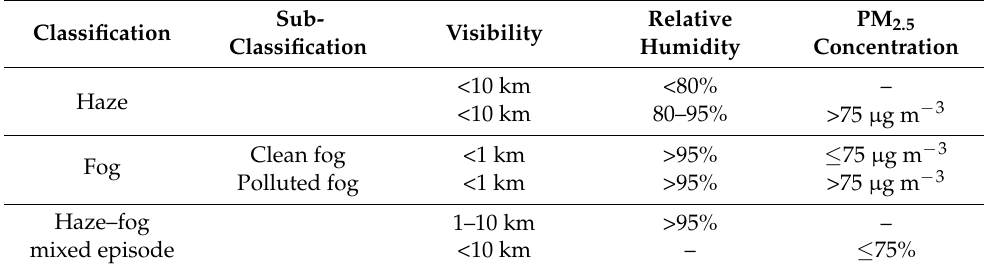
Table 2. Haze and fog classification based on visibility, relative humidity and PM 2.5